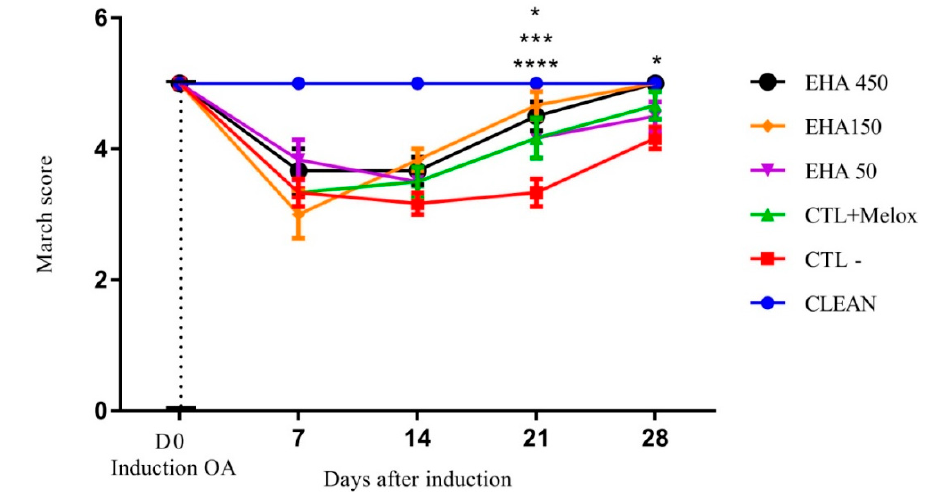
Figure 2. E ff ects of the A. chica extract on the motor activity / march score of rats with induced osteoarthritis (OA). The induction of OA was done by the injection of MIA (2 mg) in the knee of Wistar rats. After 3 days, the animals received oral saline (CTL − ), Meloxicam (CTL + Melox), and A. chica extract at doses 50, 150, and 450 mg / kg (EHA50, EHA150, and EHA450). After 7, 14, 21, and 28 days of induction, the motor activity of the animals was measured to evaluate the rotarod score. The data are represented in mean ± standard deviation of the means. The healthy group is represented by animals without osteoarthritis and without treatment (CLEAN). * represents significant di ff erences, with p < 0.05; *** with p < 0.0005; **** with p < 0.0001 comparing the treatments to the saline group.